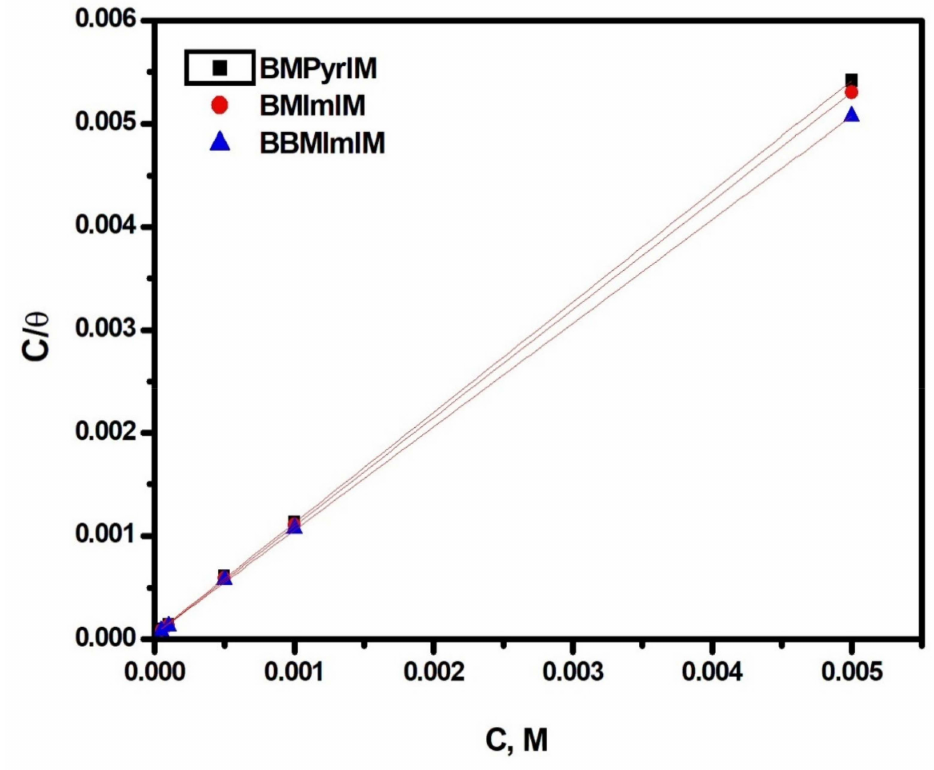
Figure 2. Langmuir isotherm for the studied ionic liquids ( BMPyrIM , BMImIM and BBMImIM ) adsorption on mild steel in 1 M HCl at 25 ◦ C. Table 3. Regression constant (R 2 ), equilibrium constant (K ads ), and free energy of adsorption ( ∆ G ads ) of the studied ionic liquids for the corrosion of mild steel in 1 M HCl at 25 ◦ C.